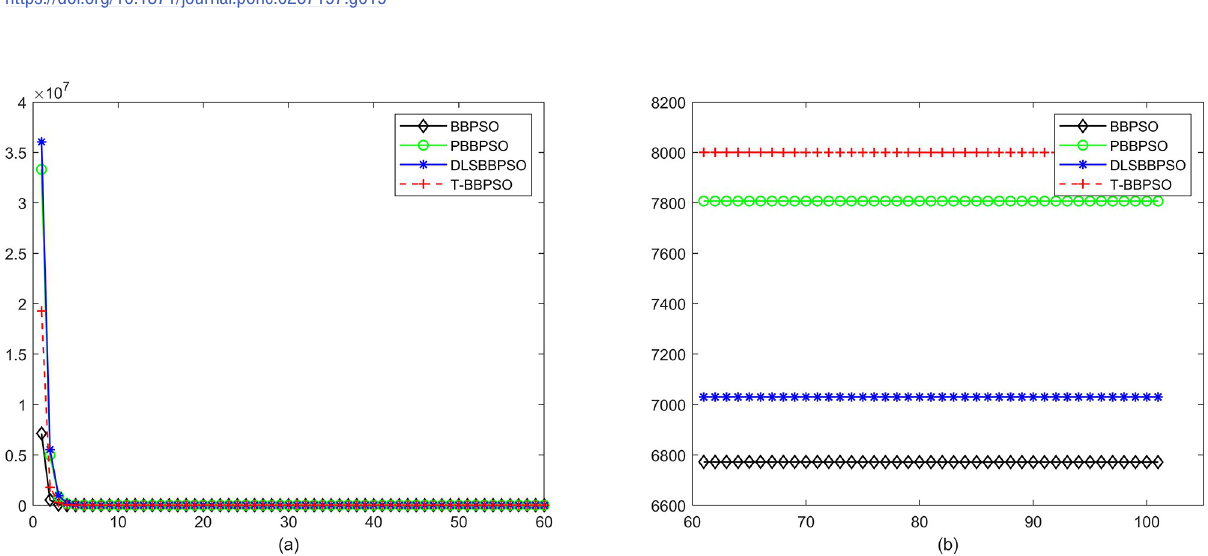
Fig 19. Comparison of convergence speed between BBPSO, PBBPSO, DLS-BBPSO and TBBPSO, f 17 , (a) iteration 0–6000, (b) iteration 6000–10000 the unit is 100 iteration.